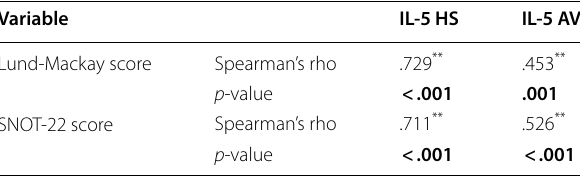
Table 4 Correlation of IL-5 with SNOT-22 score and Lund-